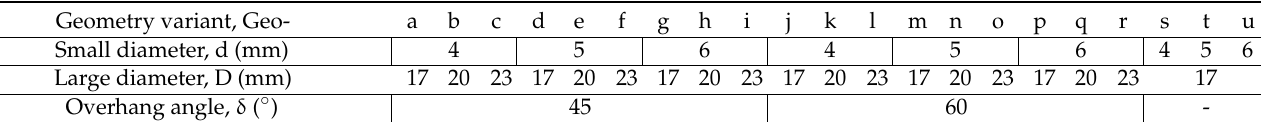
Table 1. Geometry variants of tensile test samples.